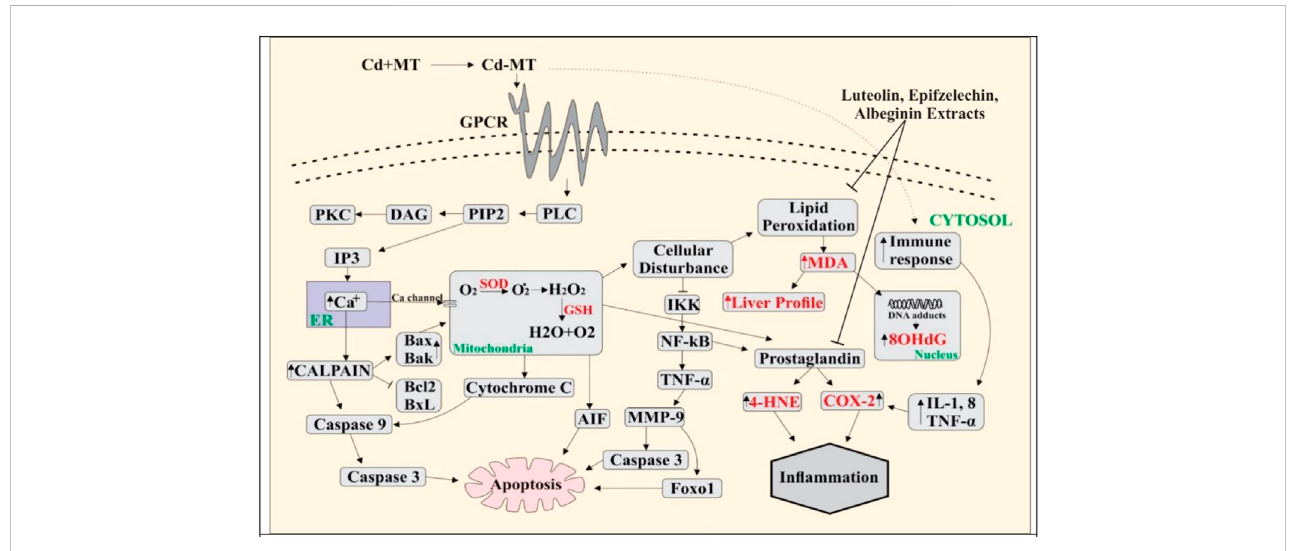
FIGURE 4 Cd enters blood by making a complex with metallothionein, and Cd binds with G-protein – metal coupled receptors on the cell surface, resulting in the activation ofphospholipase C (PLC).Activated PLC results in PIP 2 productionthat activates IP 3 ,leading to therelease of Ca 2+ fromER. Ca 2+ increases thelevel of calpain which further activates the caspases and as a result apoptosis occurs in the cell. Due to overloading, Cd enters into the mitochondria through the Ca 2+ channels and ROS is produced in excess amount. This activates cytochrome C release and induces apoptosis through the caspases. OverproductionofROScreatesthedisturbanceinnormalcellactivity.LipidperoxidationoccurswhenthelevelofMDAincreases,DNAadductsareproduced, and 8-OHdG levels are high in the nucleus. NF-kB is activated by the inhibition of IKK. NF-kB activates TNF- α , which produces MMP9, and apoptosis occurs through the activation of AKT and FOXO1. The PGE level increases by amplifying COX-2 and 4HNE. Immune response rises due to overloading Cd-activated in fl ammatory cytokines (IL-8, TNF, and IL-1), and the increase in the COX-2 level leads to in fl